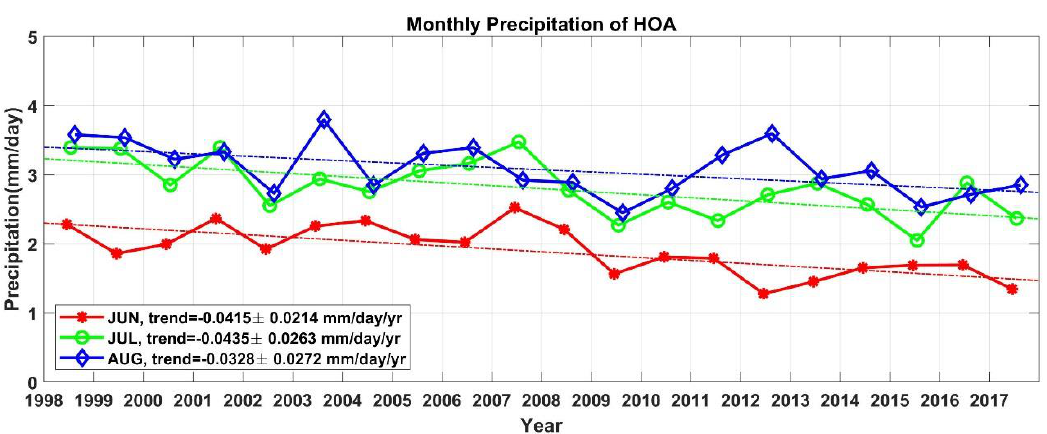
Figure 7. Monthly precipitation time series of June, July, and August, the growing period of major crops in the HOA. Table 1. Monthly rainfall trends of June, July, and August in the HOA from years 1998 to 2017.